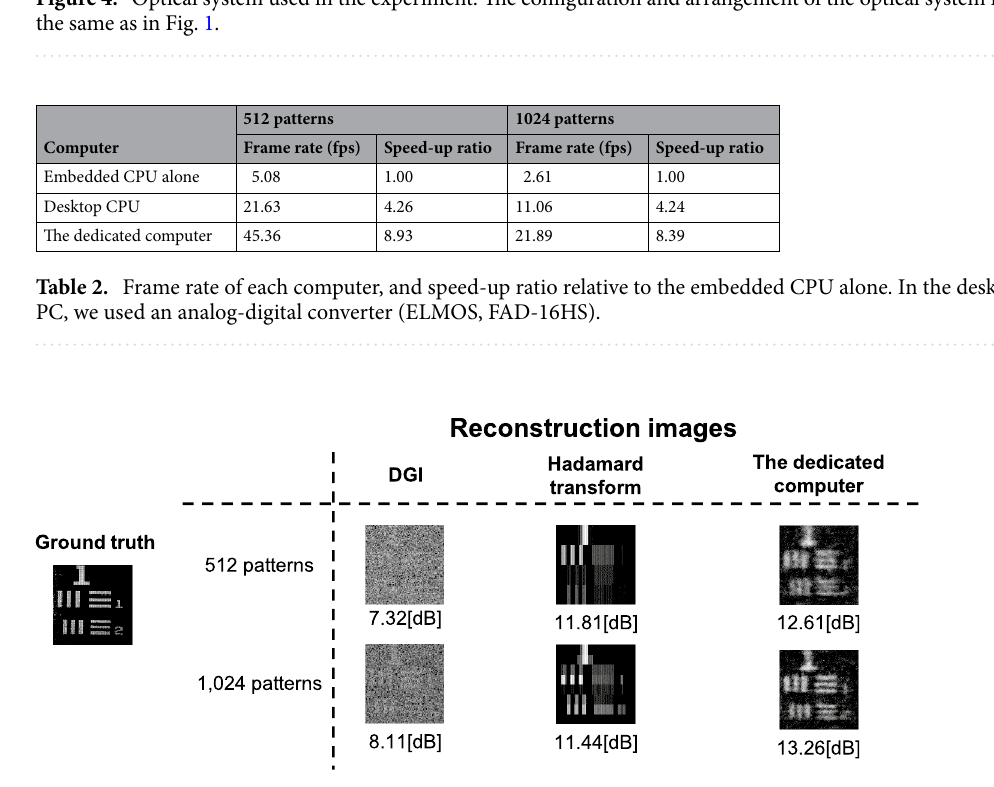
Figure 5. Reconstructed images by the dedicated computer. The image quality was evaluated by comparing with the ground truth reconstructed with the full sampling Hadamard transform. The image size is 128 × 128 pixels. Numbers of the encoding mask patterns are 512 and 1024,